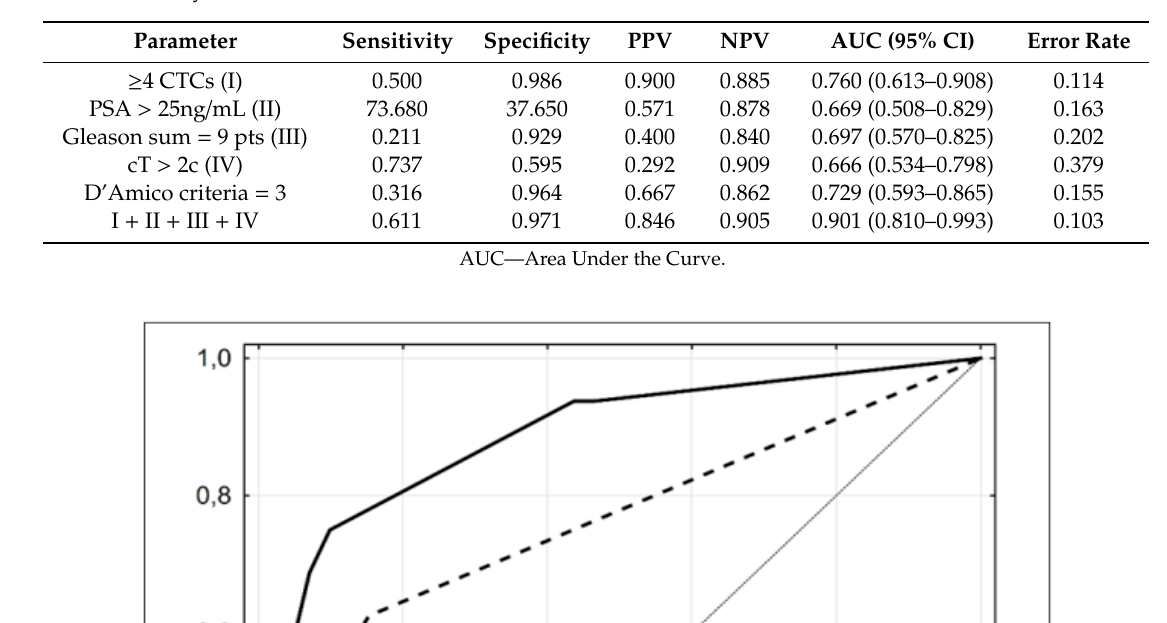
Table 5. Significant predictors of concomitant distant metastases in prostate cancer patients—results of ROC analysis.